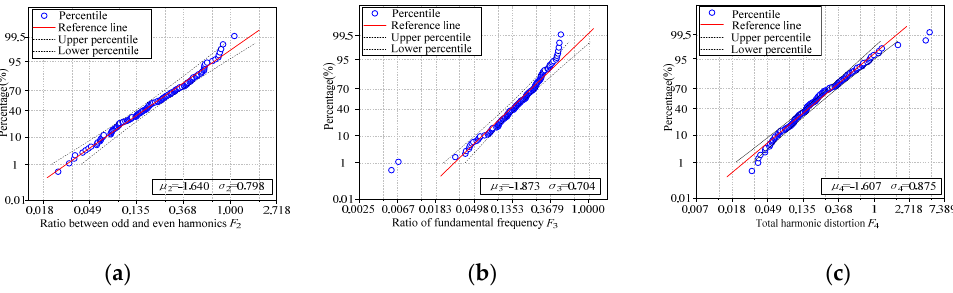
Figure 11. Lognormal probability plots of transformer acoustic typical eigenvalues. ( a ) Ratio between odd and even harmonics F 2 . ( b ) Ratio of fundamental frequency F 3 . ( c ) Total harmonic distortion F 4 .